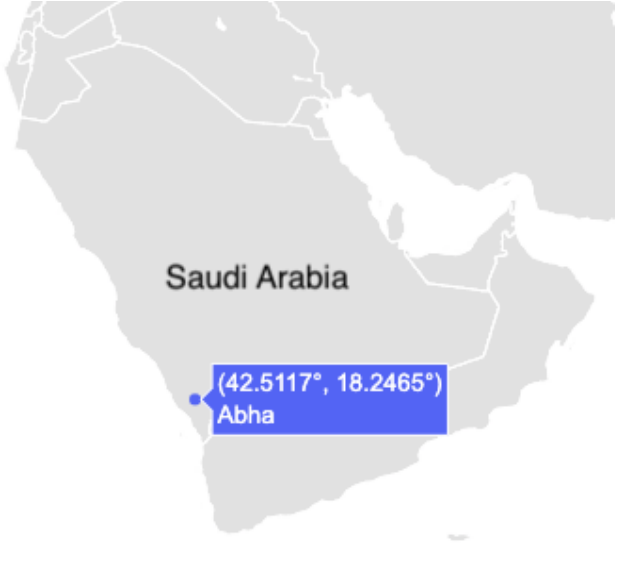
Figure 1. Geographical Location of Abha.